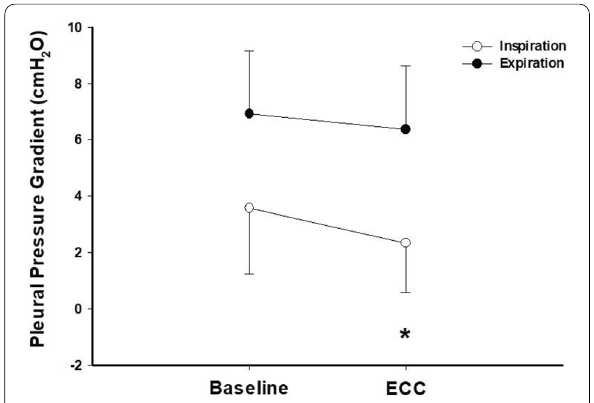
Fig. 5 Effect of ECC on pleural pressure ( P pl ) Gradient in pigs with experimental ARDS. N 4. P pl gradient was calculated as P pl dorsal– P pl = ventral, both at end-inspiration (white dots) and end-expiration (black dots). ECC external chest-wall compression. * P < 0.05 vs.